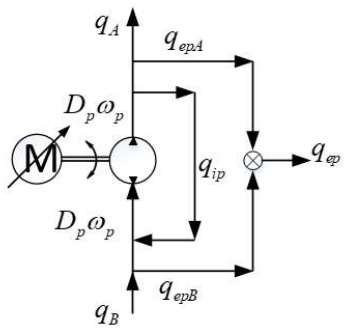
Figure 2. Flow distribution of the hydraulic pump.